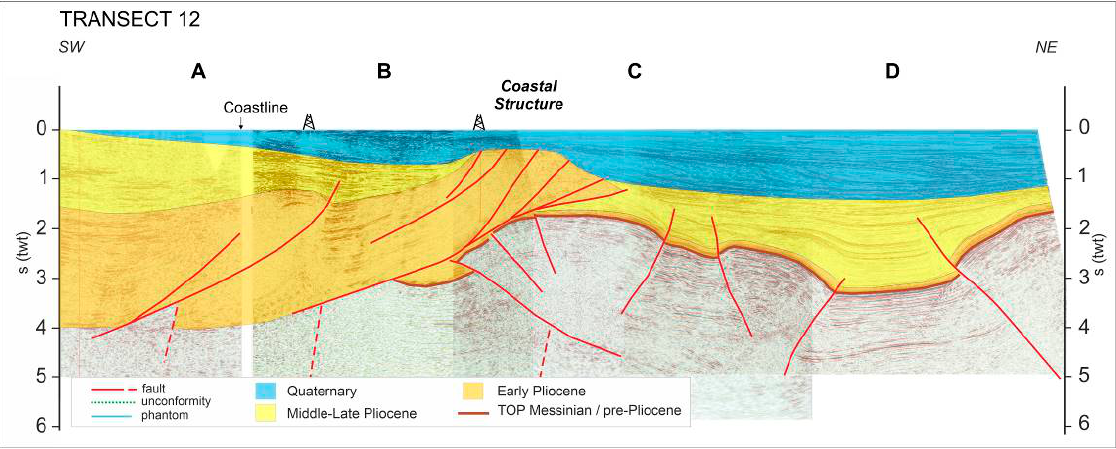
Figure 8. Transect 12.